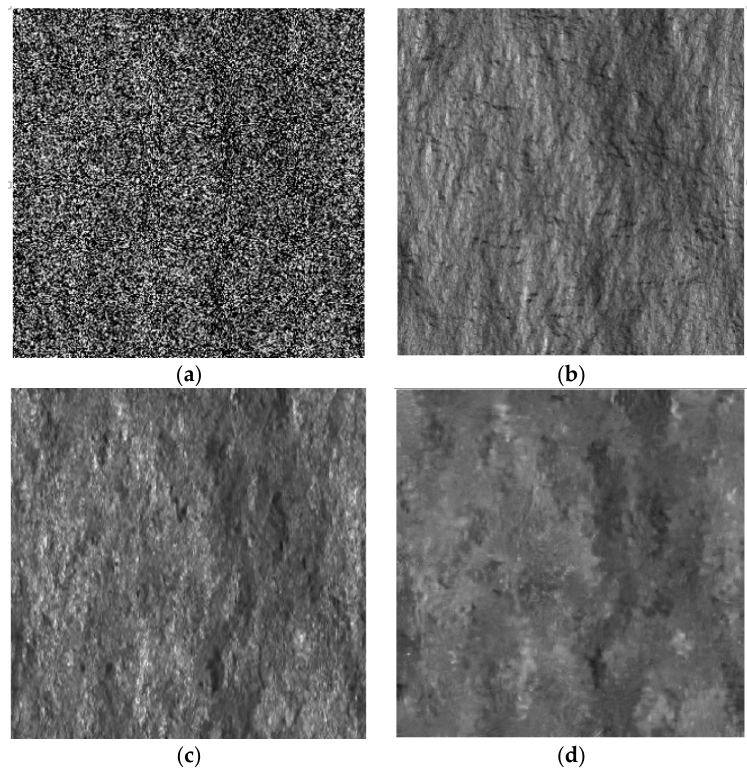
Figure 3. Simulated and despeckled SAR images relevant to the DEM in Figure 2a and assuming the cos(cid:2036) scattering model. ( a ) Noisy; ( b ) reference SAR image; ( c ) SB-SARBM3D; ( d ) SARBM3D.